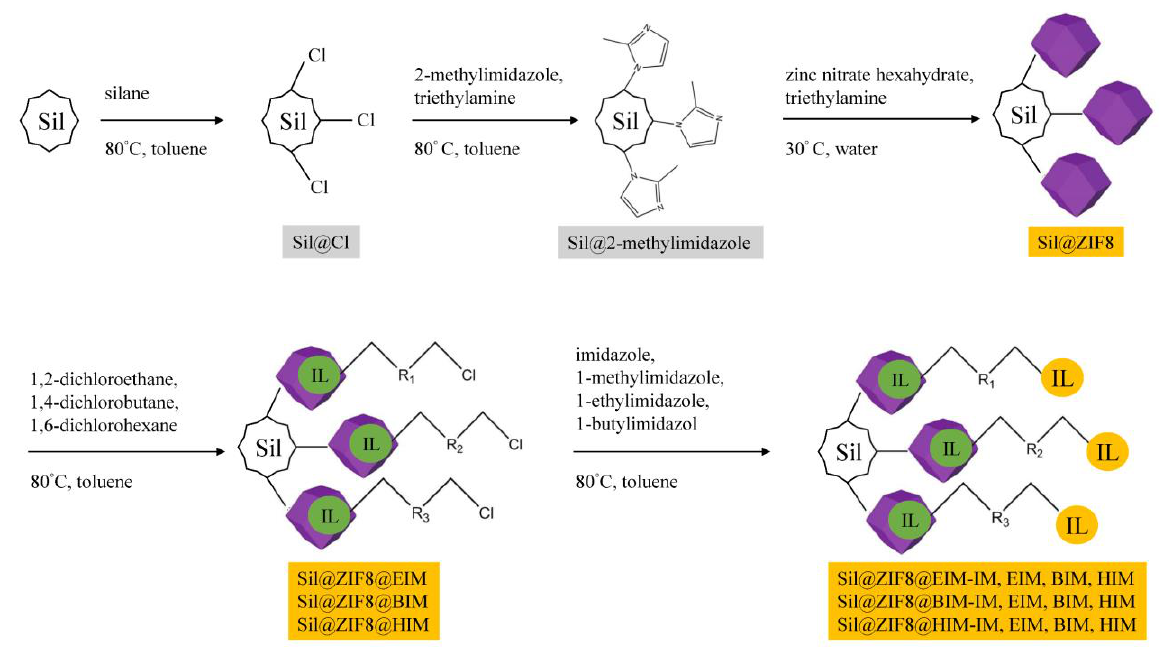
Figure 1. Synthesis process of dual ionic liquids@ZIF8-covered silica